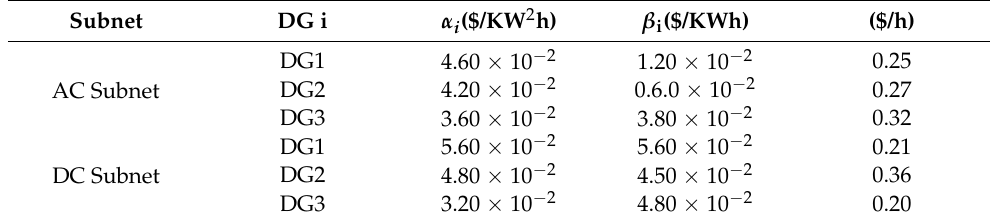
Table 1. Distributed power cost coefficient.